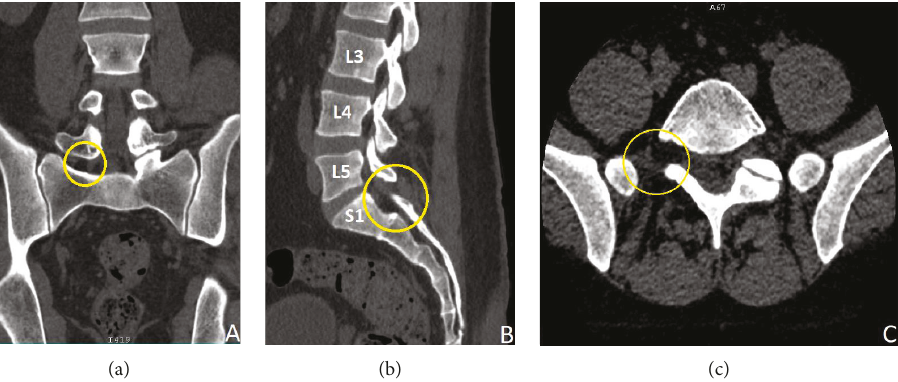
Figure 2: (a) Coronal cut of spine CT scan showing the absence of the right L5-S1 zygapophyseal joint forming a defect. (b) Sagittal cut of spine CT scan showing the absence of the L5 inferior articular process on the right with normal neighboring joints. (c) Axial CT scan cut of the spine further con fi rming the absence of the L5-S1 facet joint on the right side.